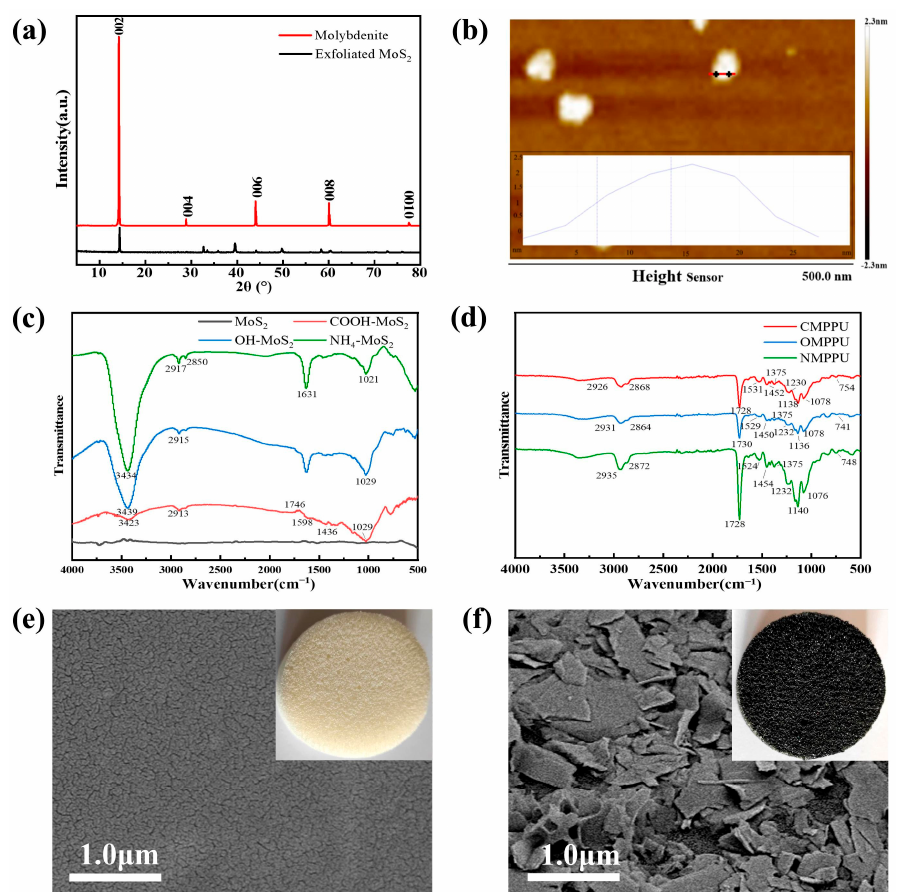
Figure 2. ( a ) XRD spectrum and ( b ) AFM images of the exfoliated MoS 2 . FTIR spectrum of ( c ) func- tionalization MoS 2 and ( d ) load functionalization MoS 2 PPU. ( e ) SEM images of raw PU sponge and ( f ) MoS 2 supported on PU sponge.